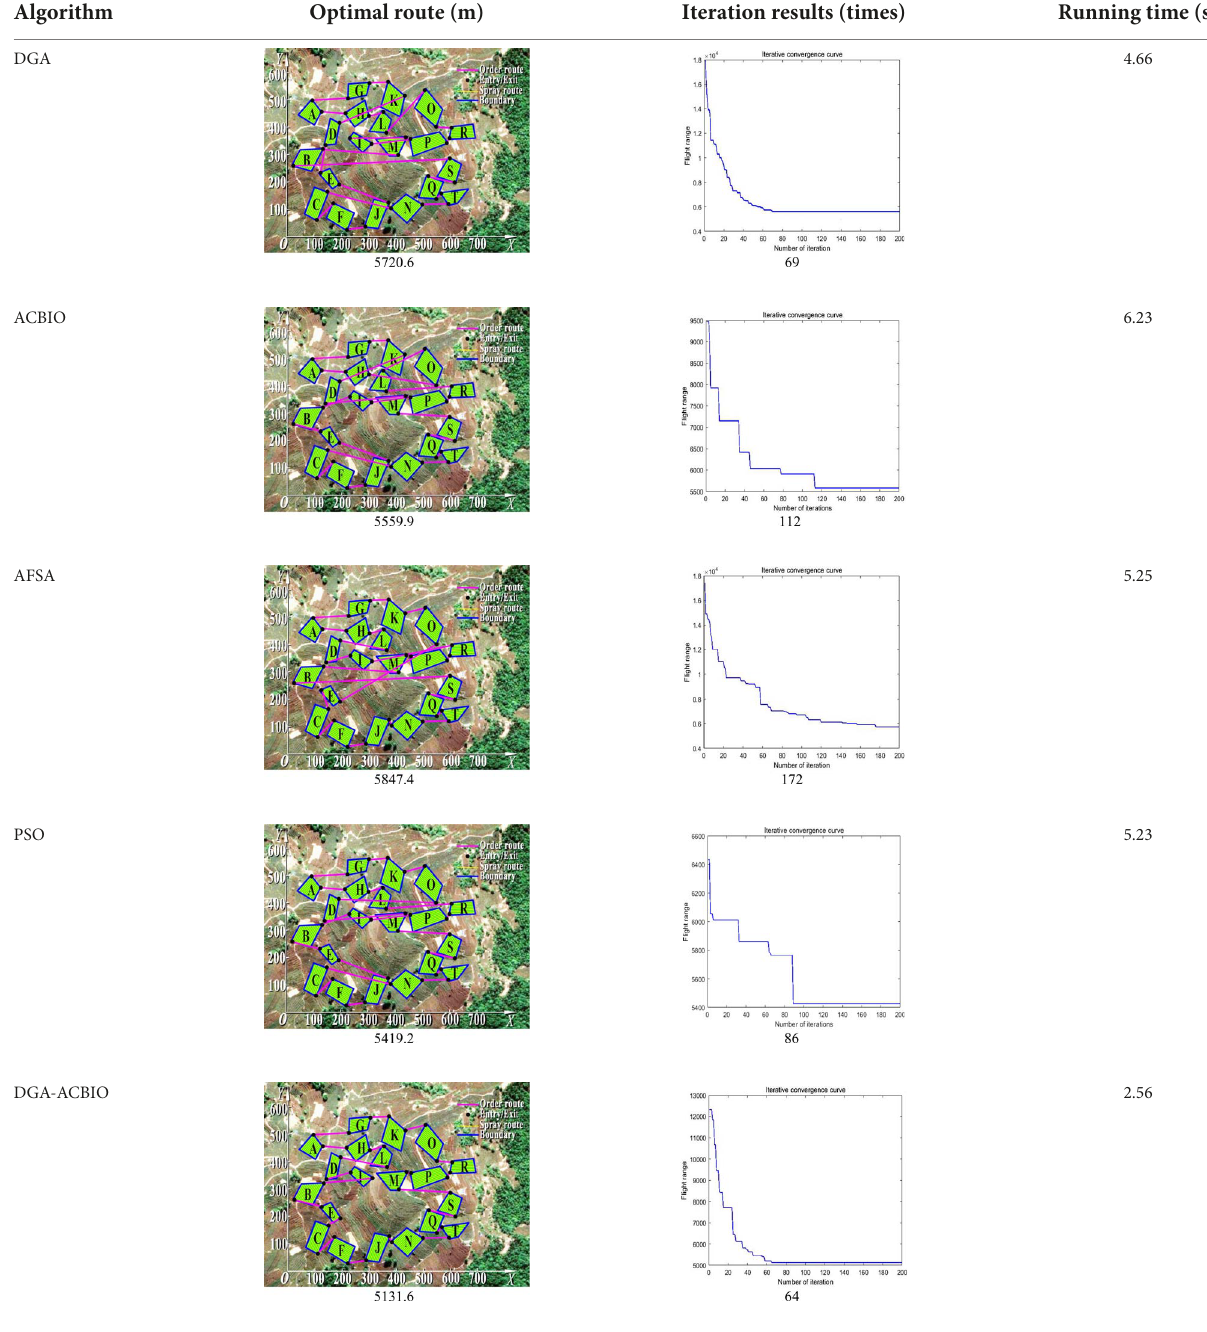
TABLE 2 Comparison of algorithm performances and optimal